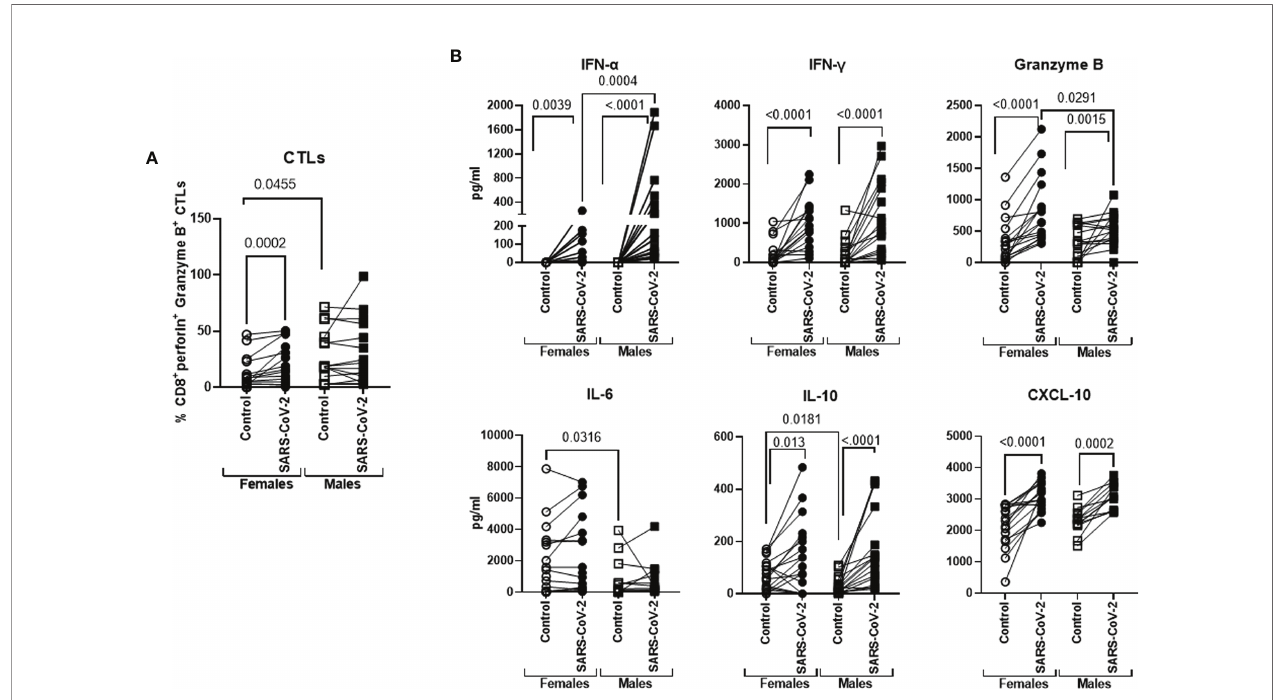
FIGURE 5 | Enhanced induction of cytotoxic CD8 T cells in females than males in response to SARS-CoV-2. PBMCs stimulated with irradiated SARS-CoV-2 were cultured for 7 days. Cells collected were stained for CD8, perforin, and granzyme B. (A) Dot plot depicts the % of these cells obtained using fl ow cytometry. (B) Quantitation of cytokines/chemokines in the supernatant by multiplex. Lines connect the unstimulated and stimulated condition from the same subject. Mean ± SE. Females = 15; males = 15. p -value between the control and SARS-CoV-2-stimulated condition in males and females was calculated using Wilcoxon matched pairs signed rank test. Signi fi cance between males and females was calculated using unpaired t